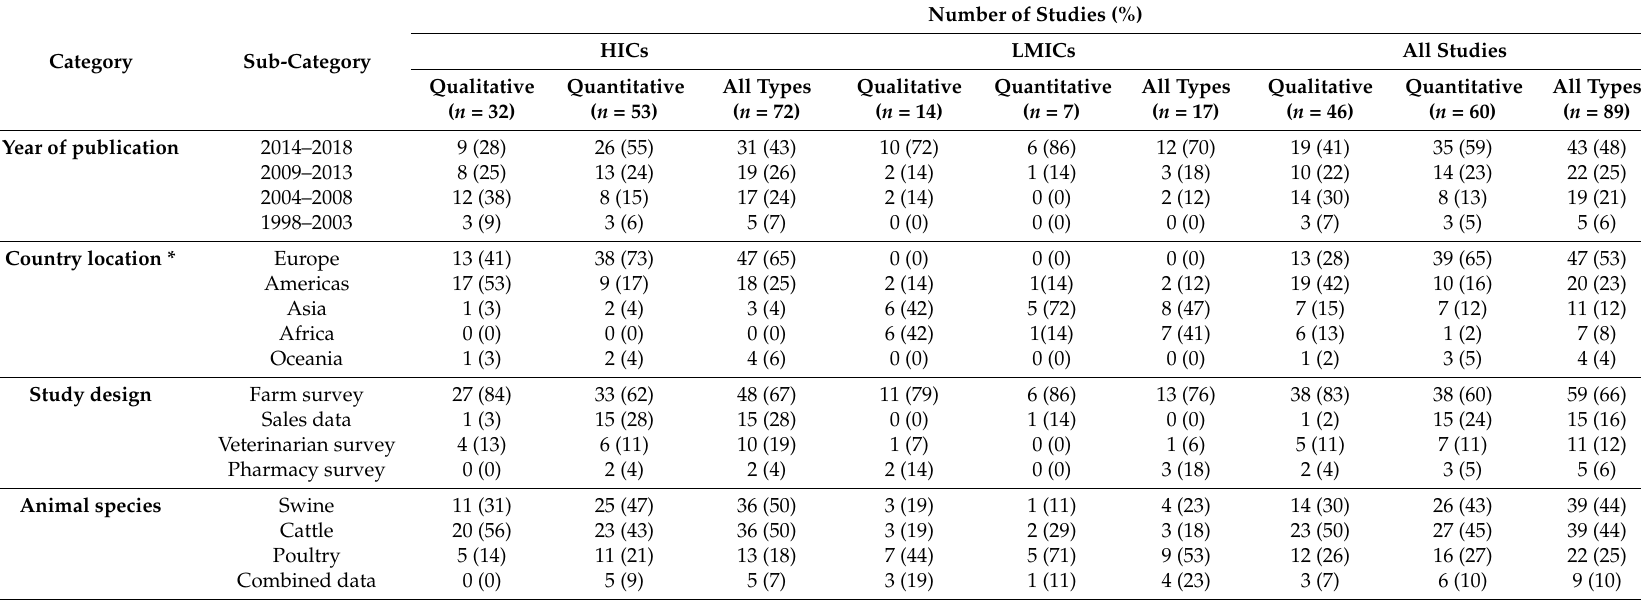
Table 1. Summary of 89 publications on antimicrobial use (AMU) stratified by year of study, country location, study design, and animal species, stratified by type of data (quantitative and/or qualitative) and type of country according to the World Bank income classification (2016). Individual studies are identified in the footnote (countries classified as low- to middle-income countries (LMICs) by the World Bank in 2016 are underlined). HICs—high-income